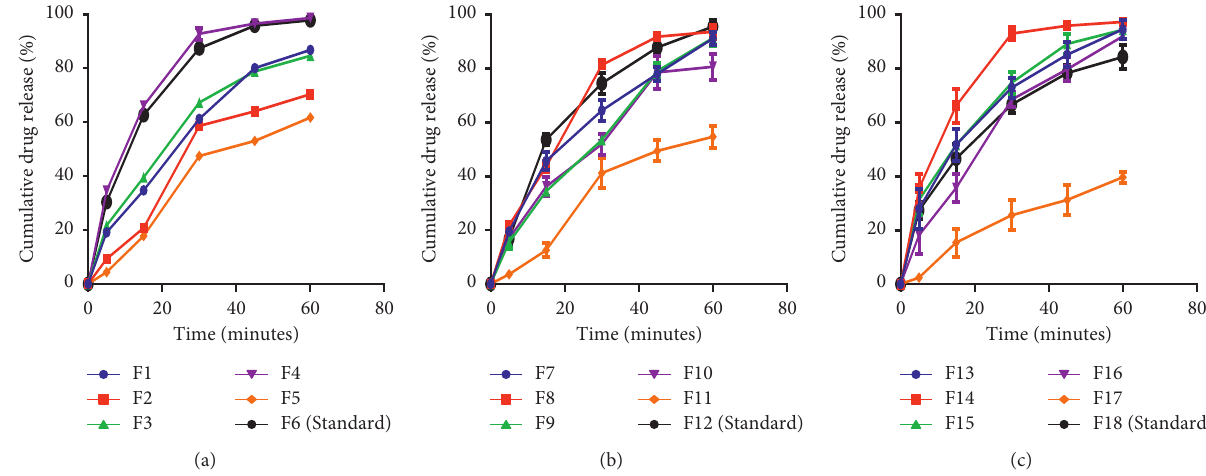
Figure 7: Dissolution profiles of formulated paracetamol tablets containing (a) ∼ 5% w/w okra pectin, (b) ∼ 7.5% w/w okra pectin, and (c)